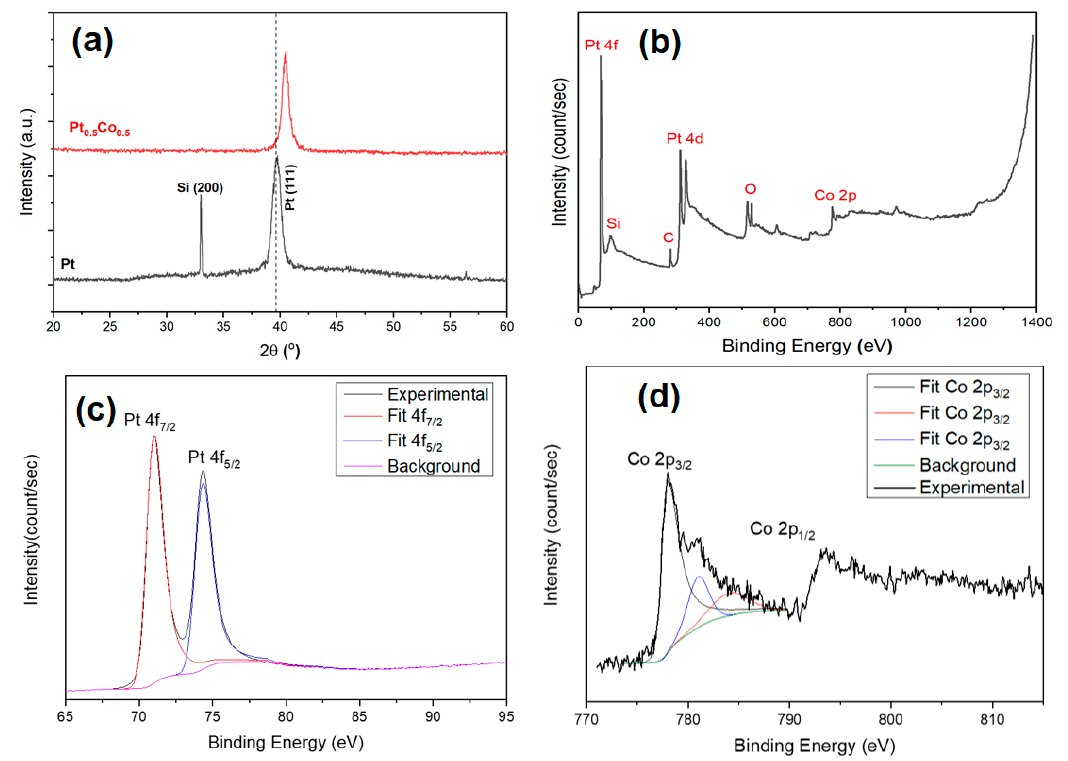
Figure 3. XRD spectrum of pristine Pt and Pt 0.5 Co 0.5 alloy thin films ( a ); the full XPS survey of Pt 0.75 Co 0.25 thin film sample ( b ), Pt 4f region ( c ), and of Co 2p region ( d ) XPS spectra of Pt 0.75 Co 0.25 alloy thin film.